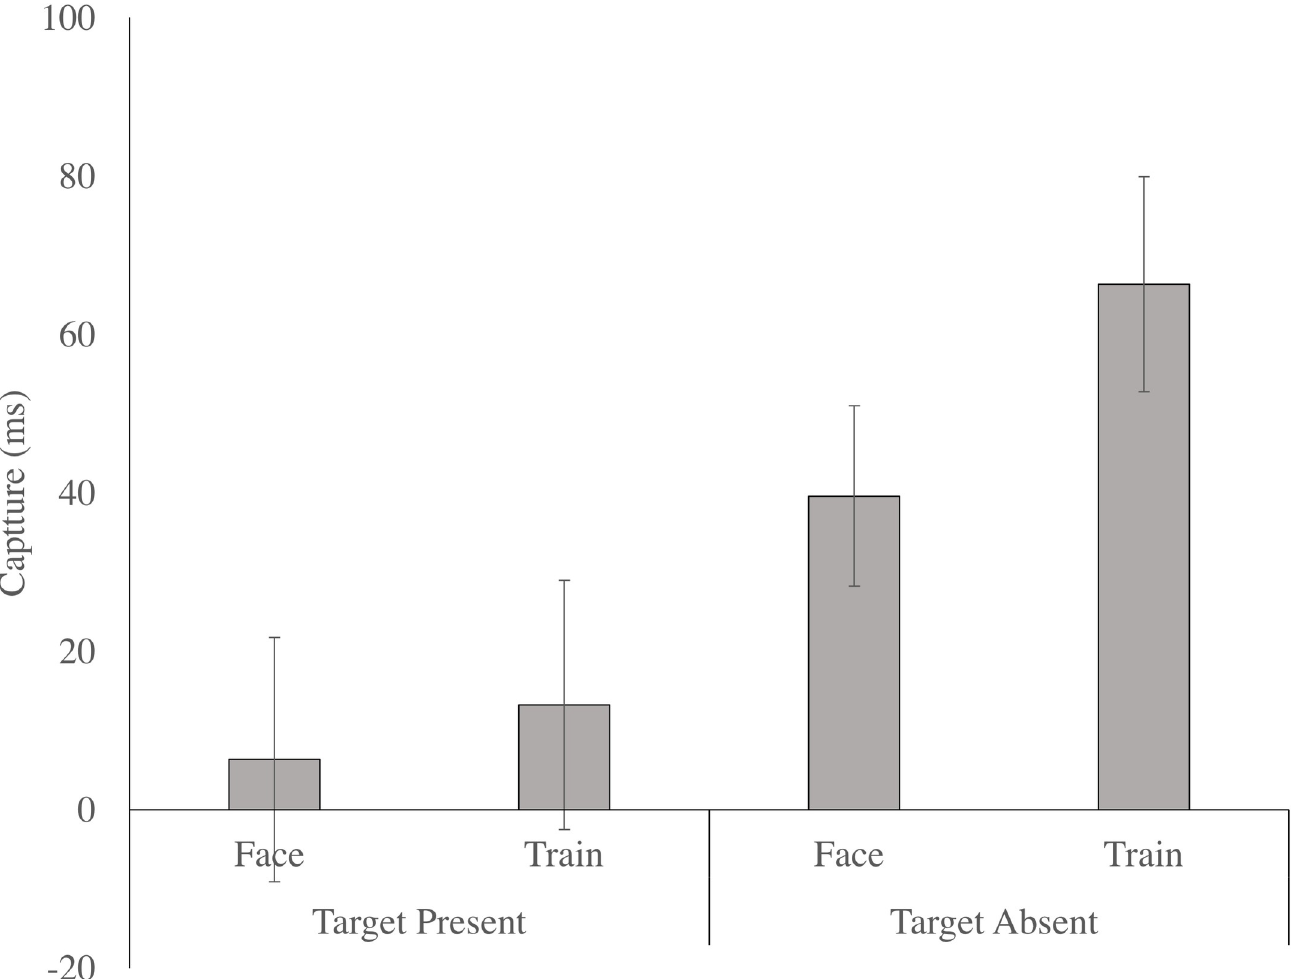
Fig 4. Attention Capture (mean and standard error) by Trains (train-neutral) and Faces (face-neutral) conditions but plotted separately for target present and target absent trials.